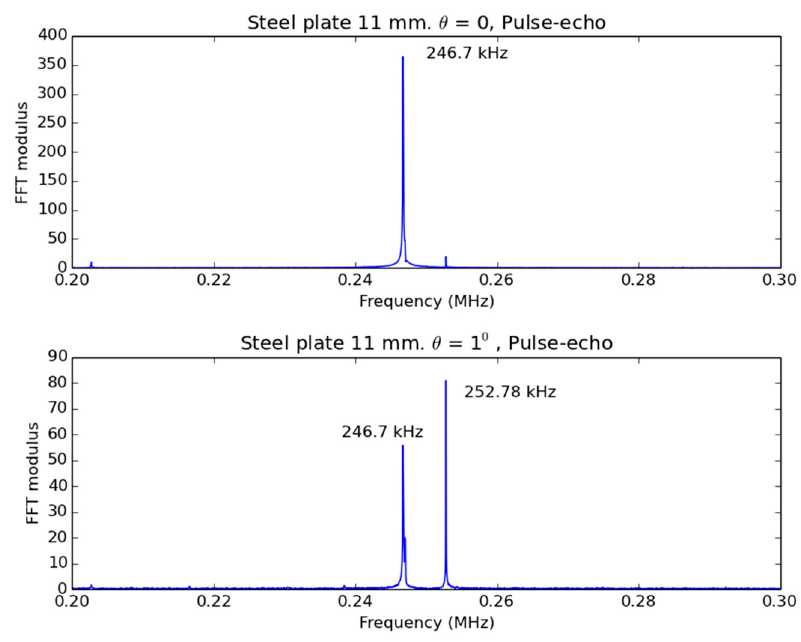
Figure 14. FFT modulus for the received signal in PE mode using a square temporal window: t 0 = 20 ms, Δ t = 19 ms for the 11 mm-thick stainless steel plate, and two values of the deviation of the angle of incidence away from normal incidence : 0° (up) and 1° (bottom).